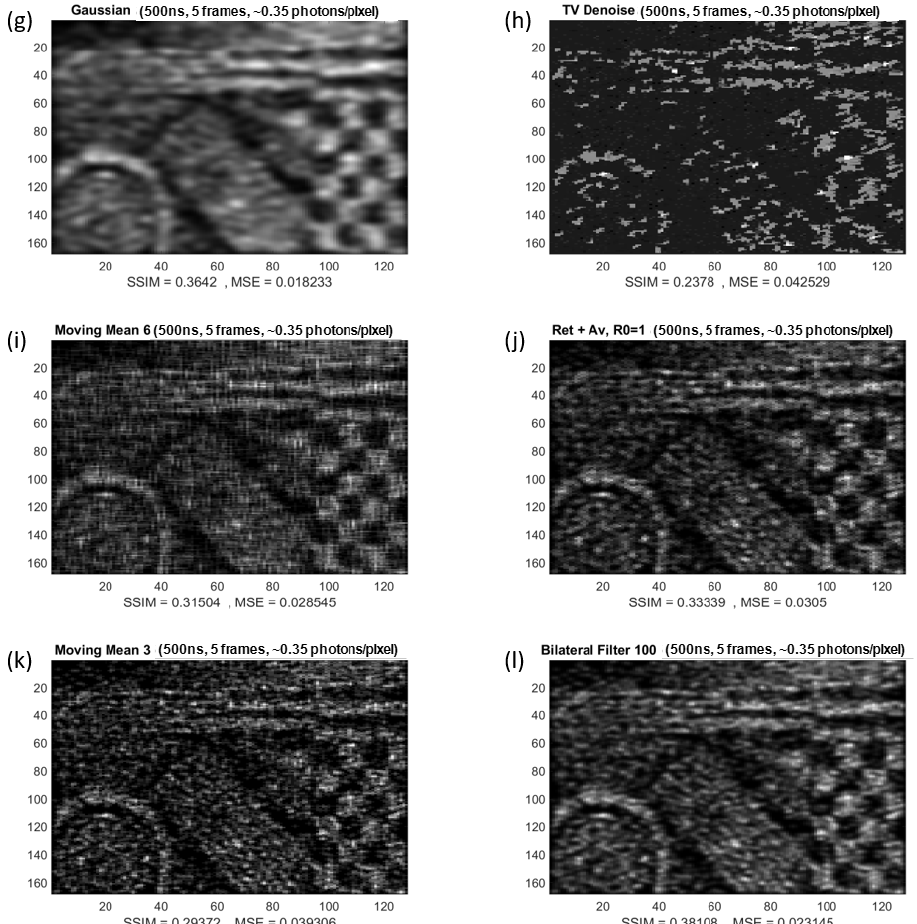
Figure A1. Example reconstructed images from a common set of 5 raw image frames of 100 ns exposures. SSIM and MSE metrics are also given. ( a ) Ground truth ( b ) High photon count reference image ( c ) Simple frame averaging ( d ) Retrodiction and averaging ( R 0 = 2) ( e ) Median filter ( f ) Bilateral filter 10 ( g ) Gaussian filter ( h ) TV denoise ( i ) Moving mean 6 ( j ) Retrodiction and averaging ( R 0 = 1) ( k ) Moving mean 3 ( l ) Bilateral filter